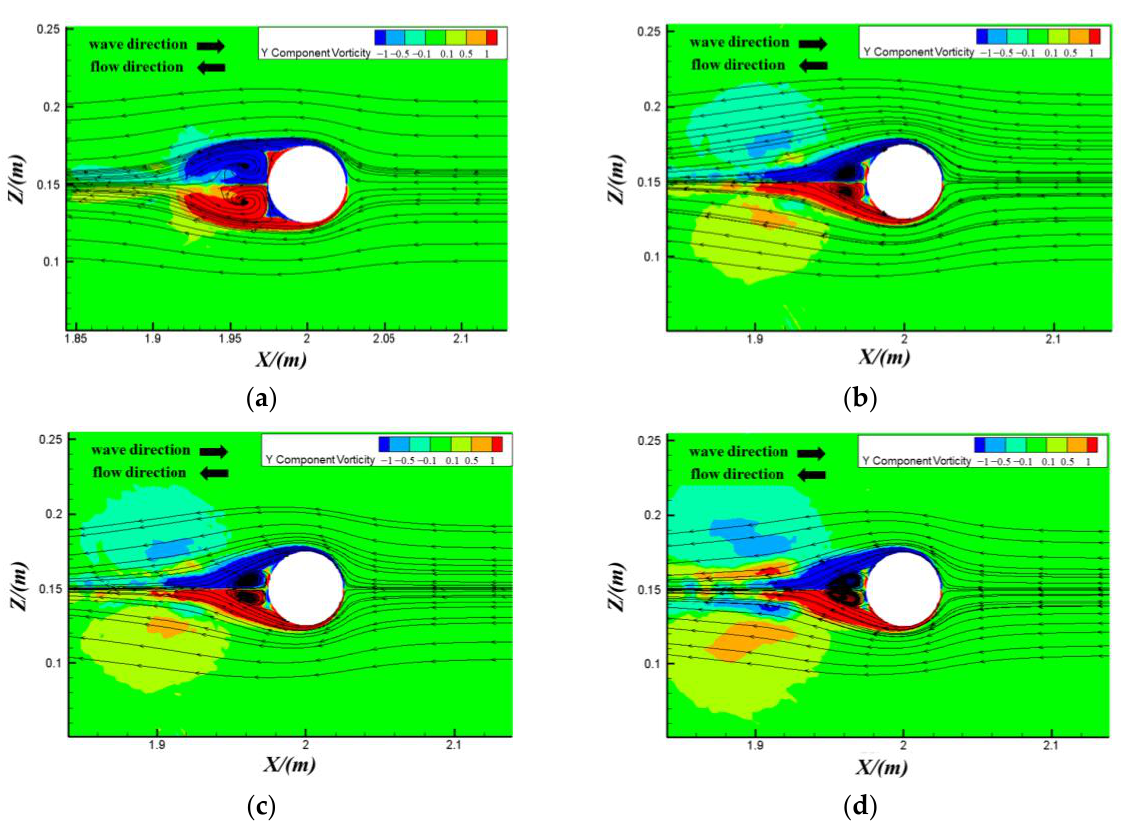
Figure 12. Plots of vorticity around cylinder at P 014 : ( a ) N 1 , ( b ) N 2 , ( c ) N 3 , ( d ) N 4 , when C Fn = C Fn-max.